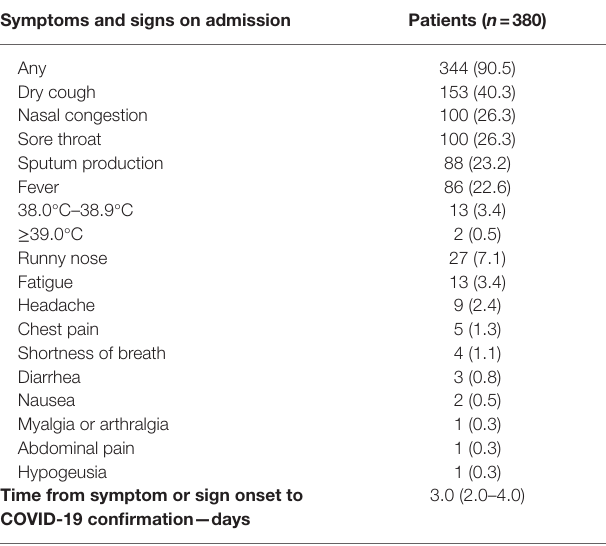
TABLE 4 | Imaging and laboratory findings of patients upon admission. TABLE 3 | Clinical characteristics of patients on